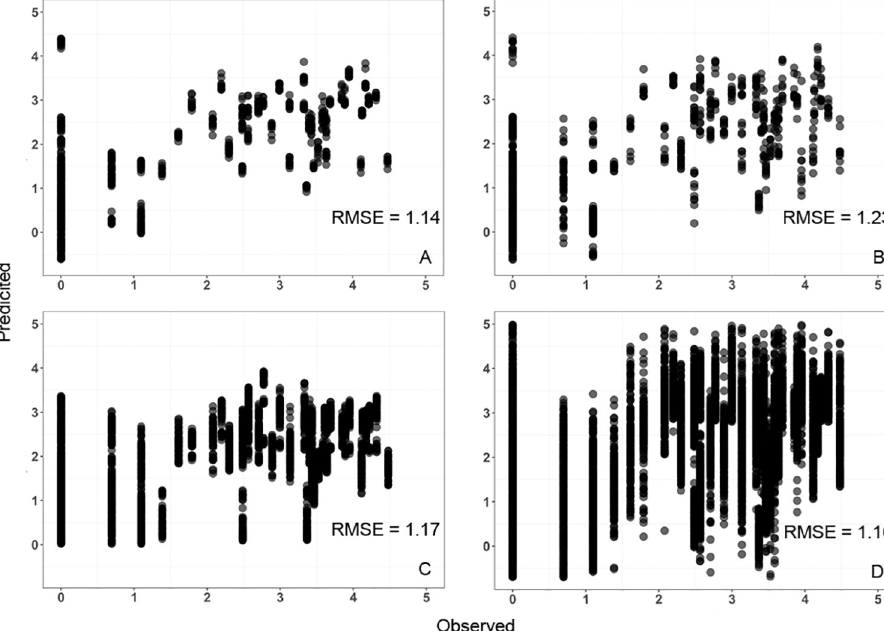
Fig 6. Predictive performance of statistical learning methods. Verticillium wilt symptoms predicted by the supervised learning methods versus observed and predictive performance, expressed as root mean square error (RMSE), of the (A) multiple linear regression model, (B) generalized additive model, (C) random forest, and (D) artificial neural networks.